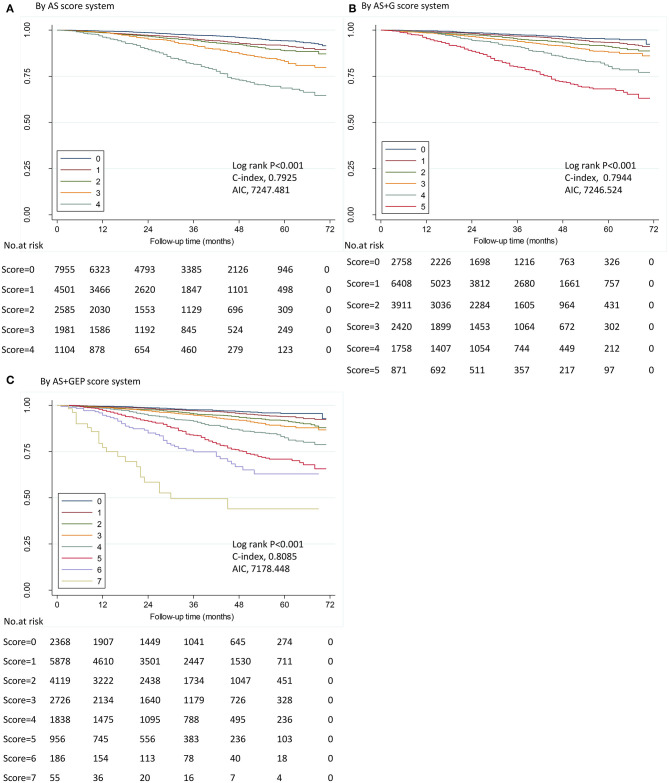
Disease-specific survival by score in ILC cohort. Kaplan–Meier survival plots demonstrated DSS in different stages determined by five score systems in ILC cohort. ILC, invasive lobular carcinoma; AIC, Akaike information criterion. (A) by anatomic stage (AS) score system; (B) by AS plus tumor grade (AS+G) score system; (C) by AS plus tumor grade plus estrogen receptor (ER) status plus progesterone receptor (PR) status (AS+GEP) score system. IDC, invasive ductal carcinoma; ILC, invasive lobular carcinoma; AIC, Akaike information criterion.